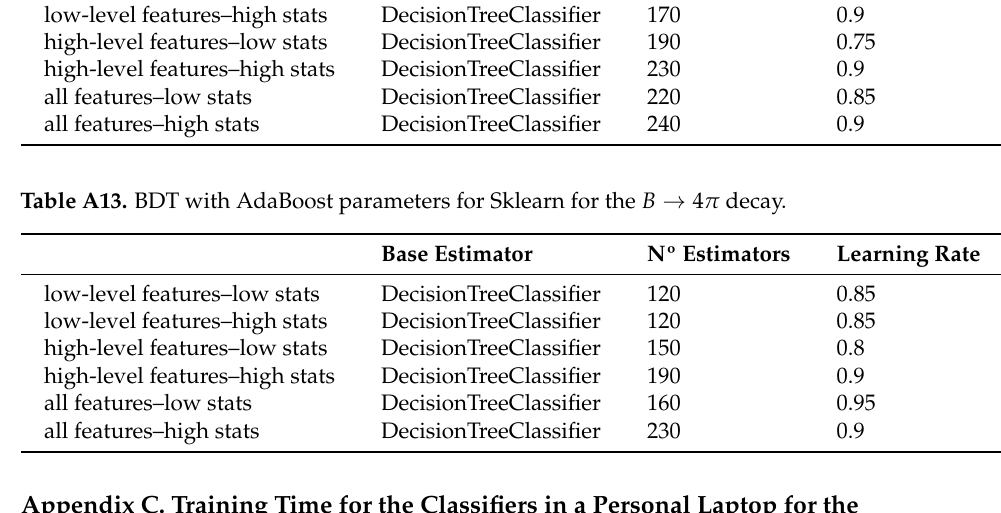
Table A12. BDT with AdaBoost parameters for Sklearn for the B